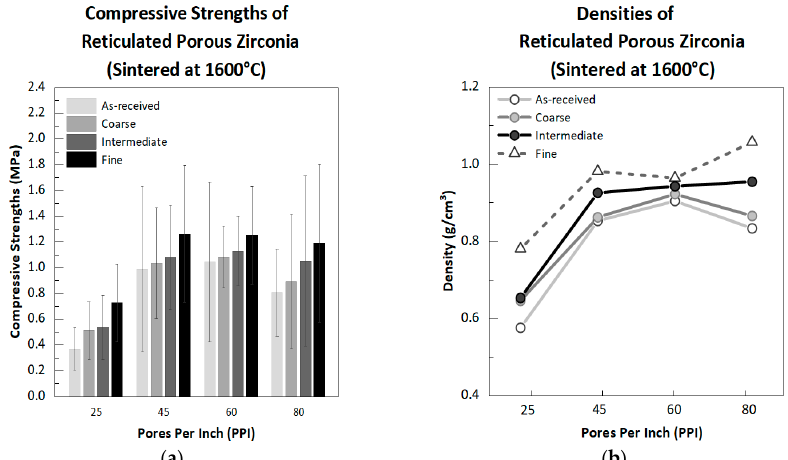
Figure 11. ( a ) Compressive strength outcomes of the reticulated porous zirconia prepared from the as-received, coarse, intermediate, and fine zirconia particles when sintered at 1600 °C, and ( b ) the corresponding density levels.